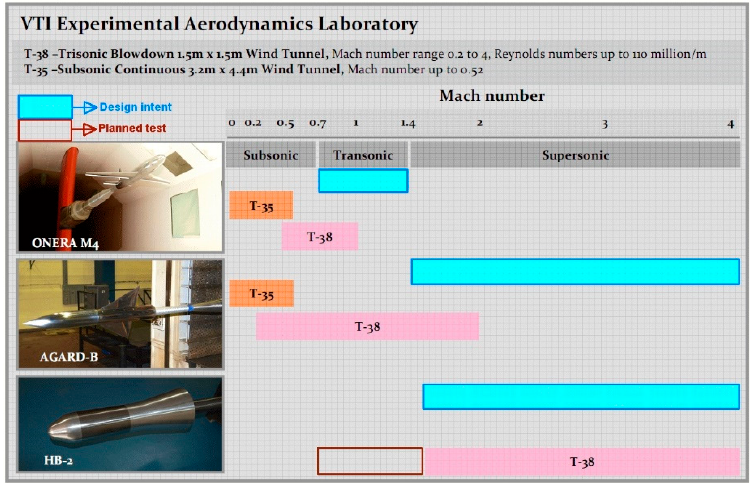
Figure 1. Initially intended and VTI-used Mach number ranges for static tests of standard